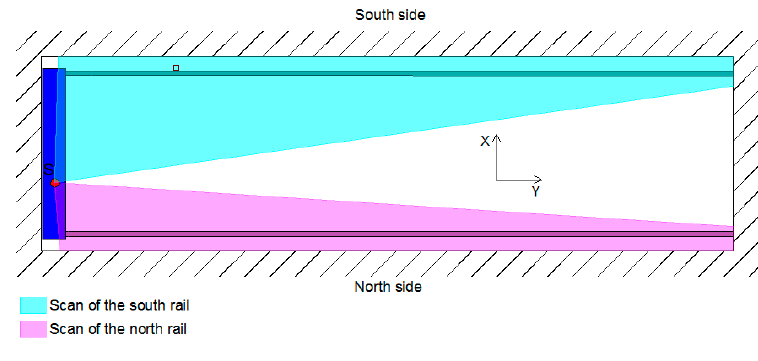
Figure 8. The scan of the rails.